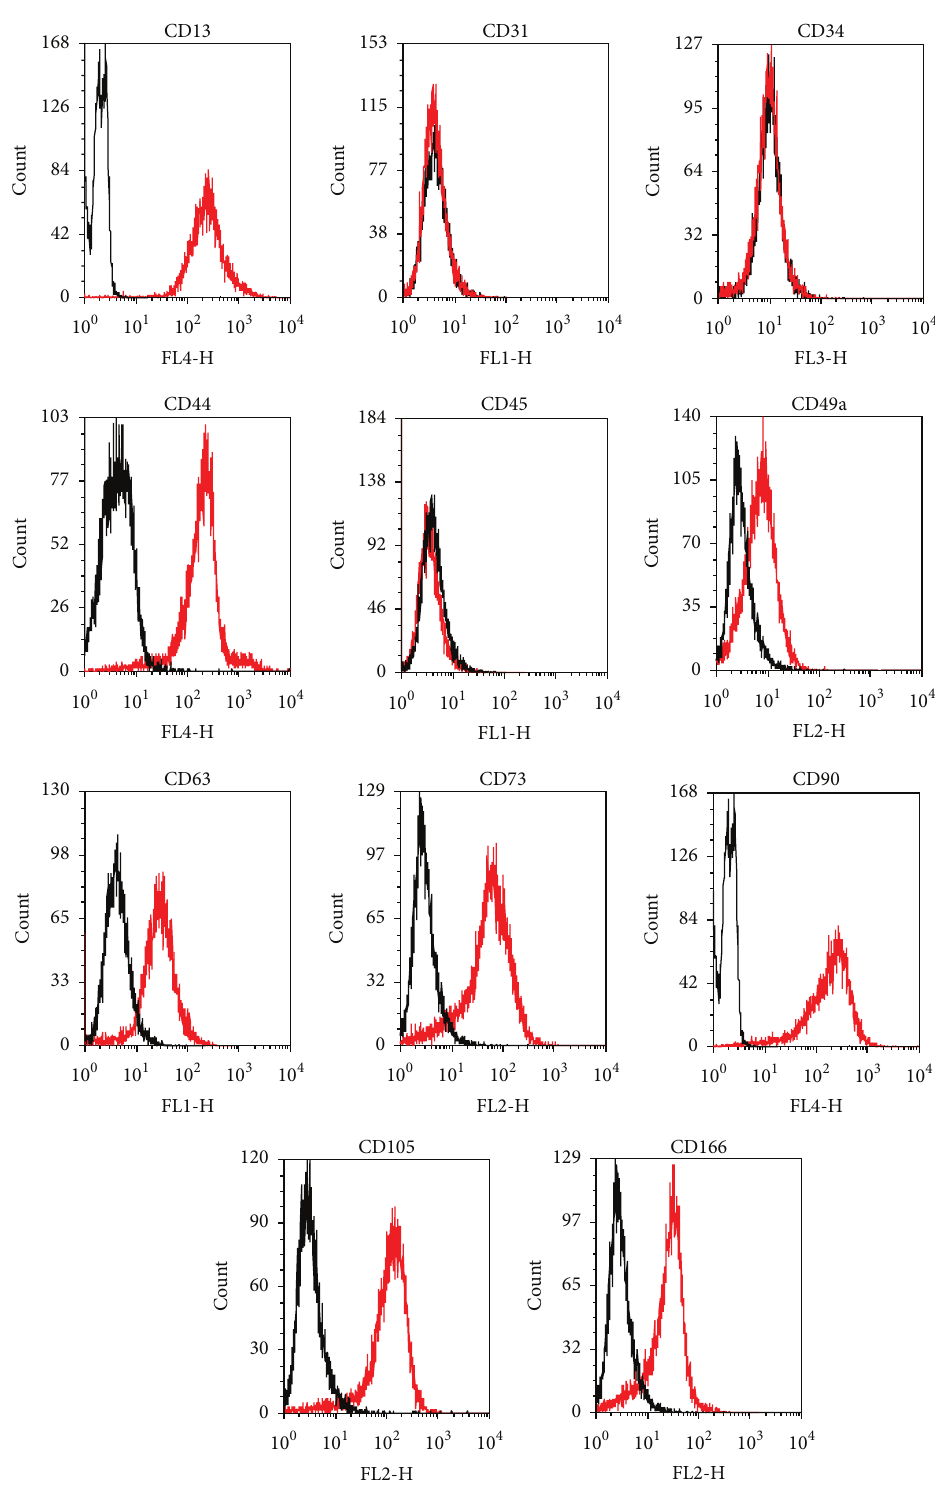
Figure 1: Results of flow cytometry. Black lines represent isotype controls and red lines the analyzed ADSC pool from six different donors. ADSC are positive for CD13, CD49a, CD63, CD73, CD90, CD105, and CD166 and negative for CD31, 34, and